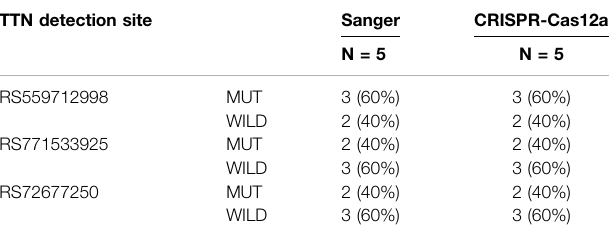
TABLE 3 | Analysis of TTN Gene Mutation Results by CRISPR test and Sanger Sequencing in Family Samples. TTN detection